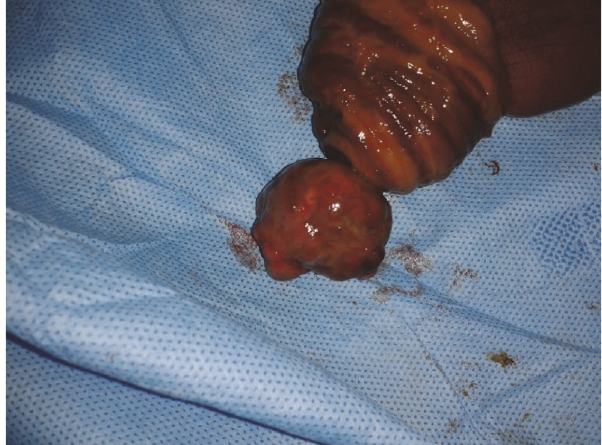
Figure 2: Macroscopic appearance of the resected specimen, show- ing a 3 cm pedunculated polyp.